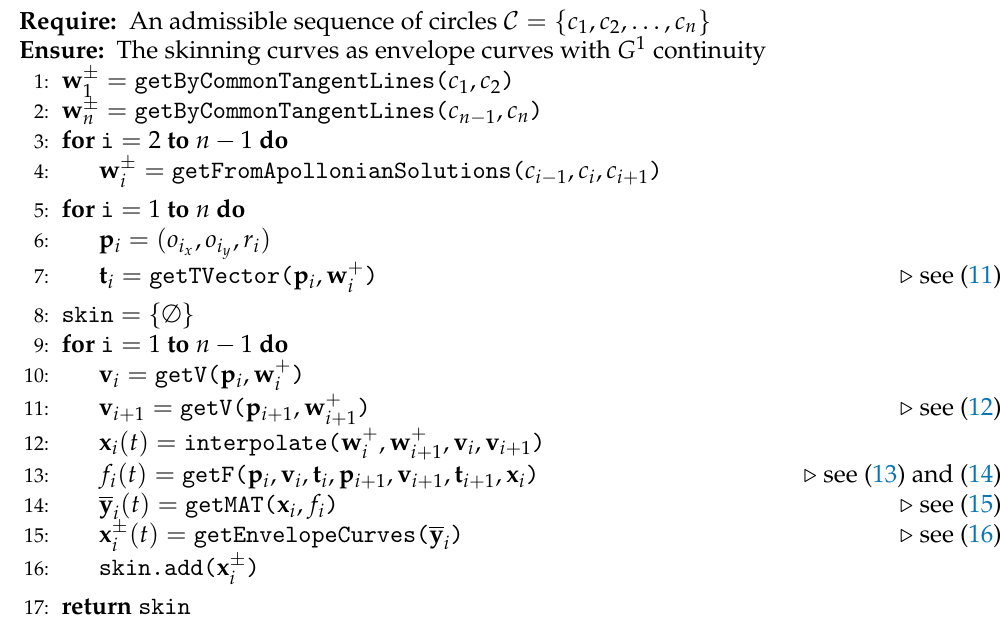
Algorithm 1 A flexible approach for using RE/MPH curves for skinning purposes